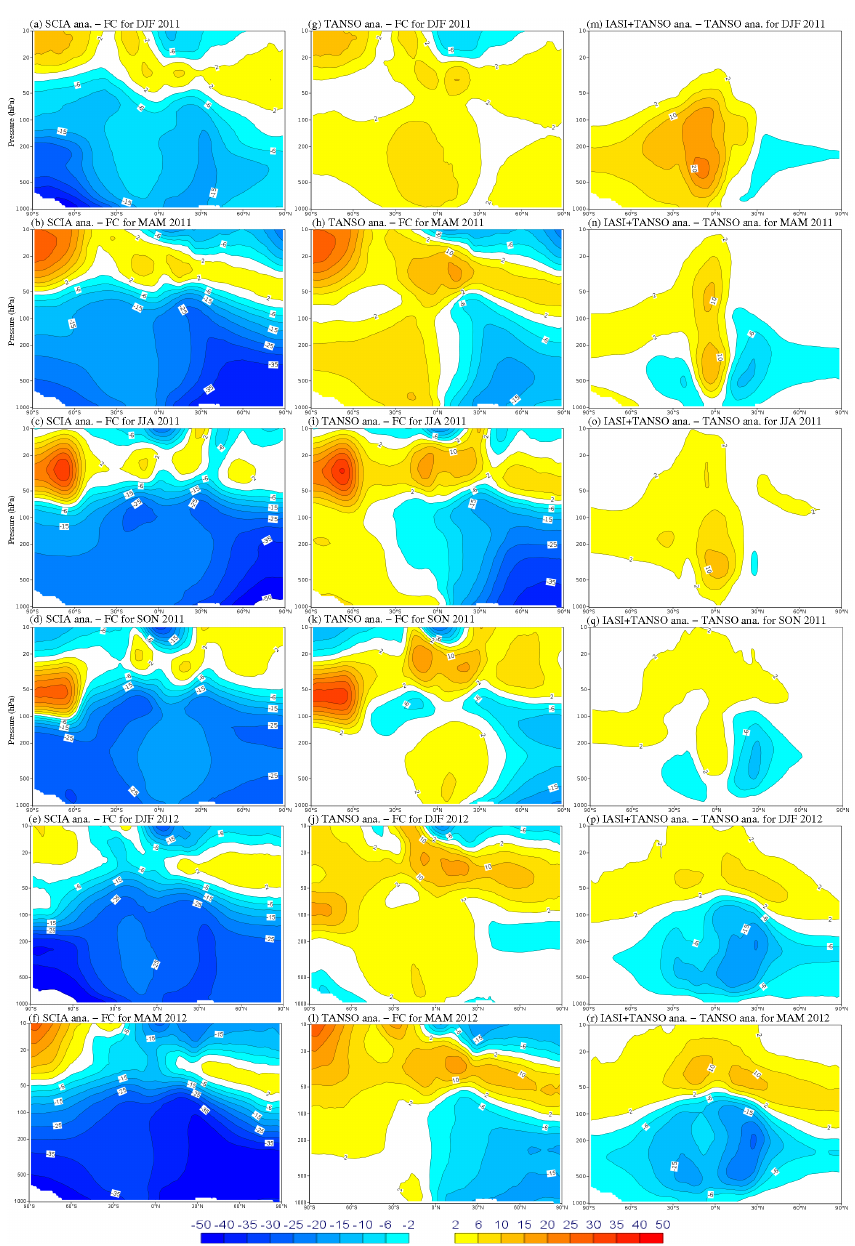
Figure 8. Seasonal and zonal mean difference between the CH 4 mole fraction (in ppb): from the SCIA experiment and the FREE free run (left); from the TANSO experiment and the FREE free run (middle); from the IASI+TANSO experiment and the TANSO experiment (right). The seasonal means are from the top to the bottom row: DJF 2010/2011, MAM 20111, JJA 2011, SON 2011, DJF 2011/2012 and MAM 2012.